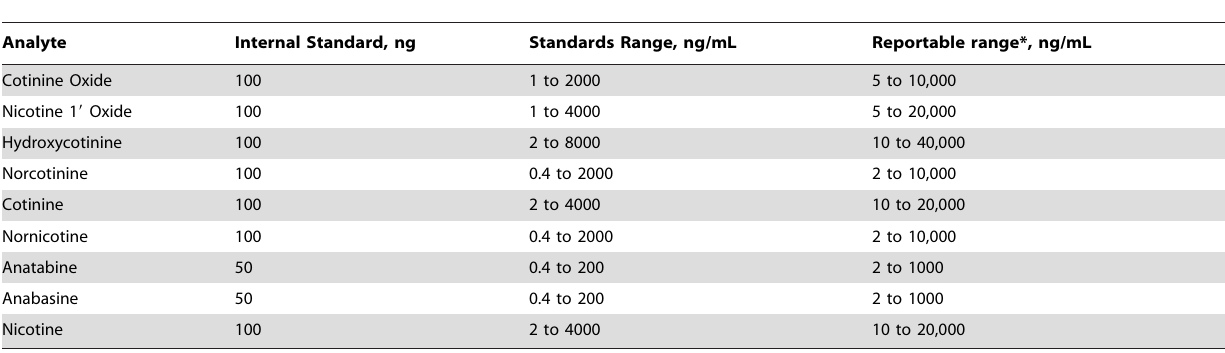
Table 1. Standard Concentrations and Reportable Ranges (sample volume 200 m L urine–1:5 dilution factor).